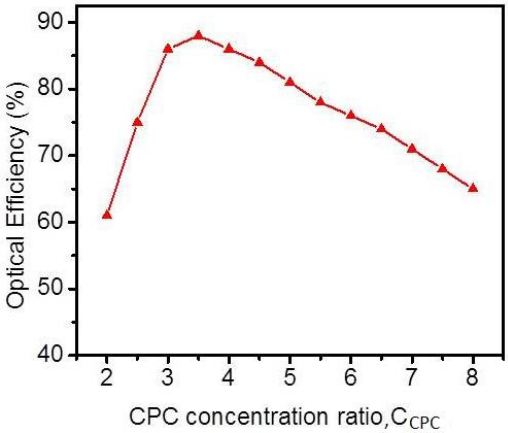
Figure 8. Variation of optical efficiencies at different C CPC concentration ratios for the CPC.